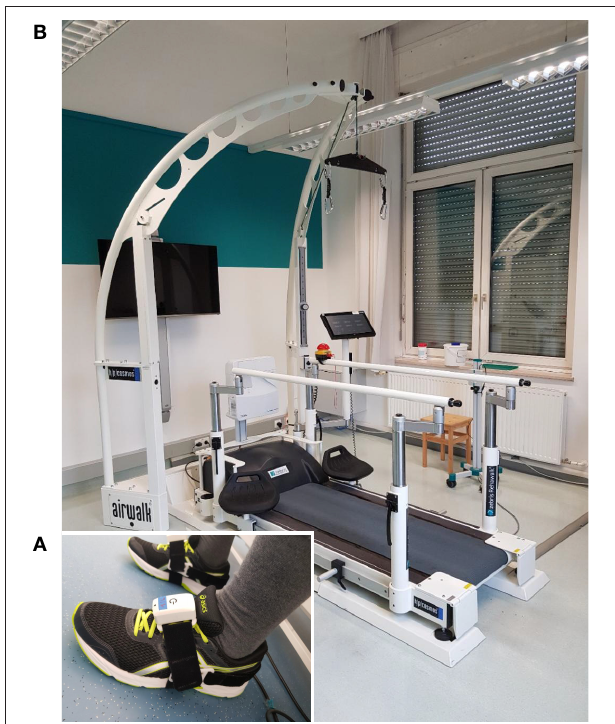
FIGURE 9 | Experimental setup. (A) Patient with inertial sensors attached to the shoe. (B) Instrumented treadmill at NTK Kapfenberg. Gait parameters are derived from the measurement data of the inertial sensors with the proposed methods and validated against parameters obtained from the instrumented treadmill serving as ground